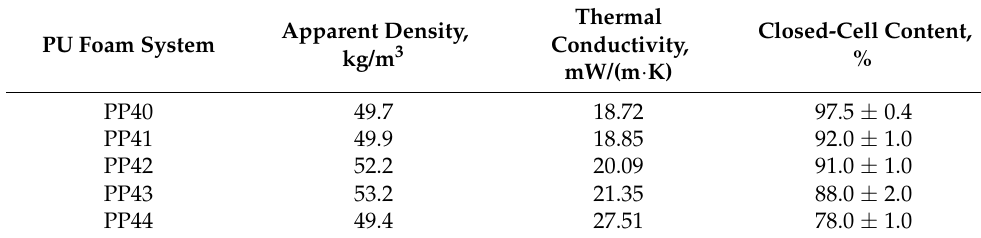
Table 6. Selected physical properties of rigid PUR foams. PU Foam